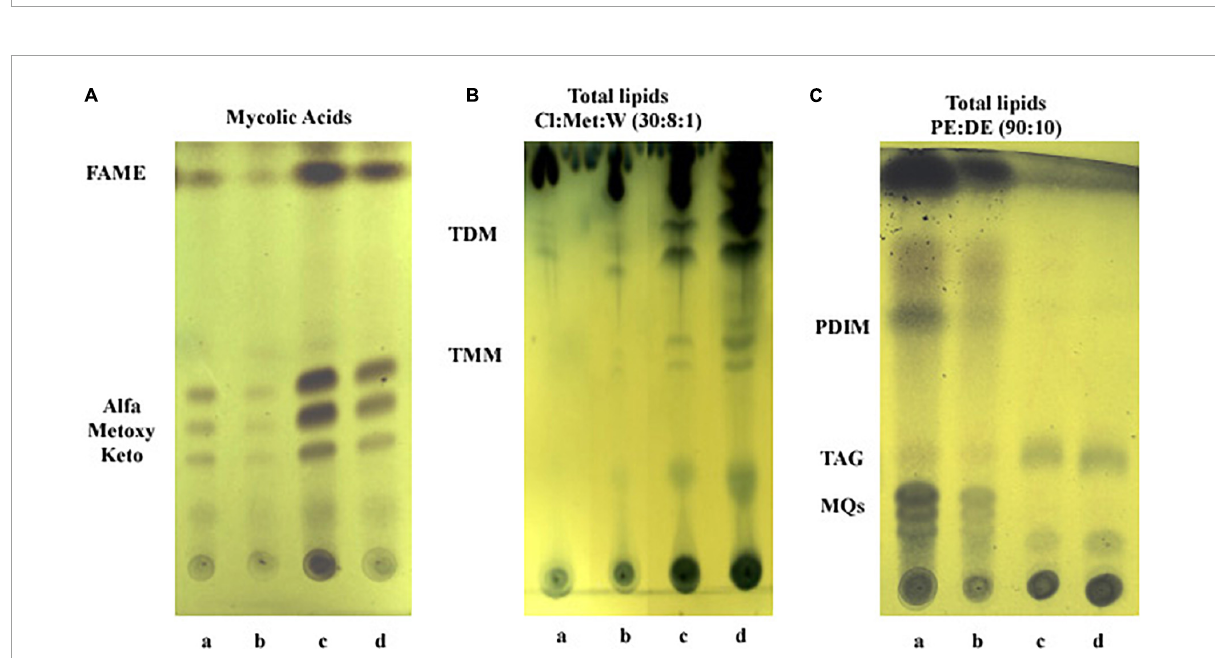
FIGURE7 Analysis of lipid content by thin layer chromatography. (A) Mycolic acids. FAME, fatty acids methyl esters. (B) Polar lipids: TDM, trehalose dimycolate; TMM, trehalose monomycolate; Cl, chloroform; Met, methanol; W, water. (C) Apolar lipids: PDIM, phthiocerol dymycocerosate; TAG, triacylglycerol; MQs, menaquinones; PE, petroleum ether; DE, diethyl ether. Lanes: a, Exp5–Fe; b, Exp5+Fe; c, Stat6–Fe; and d,